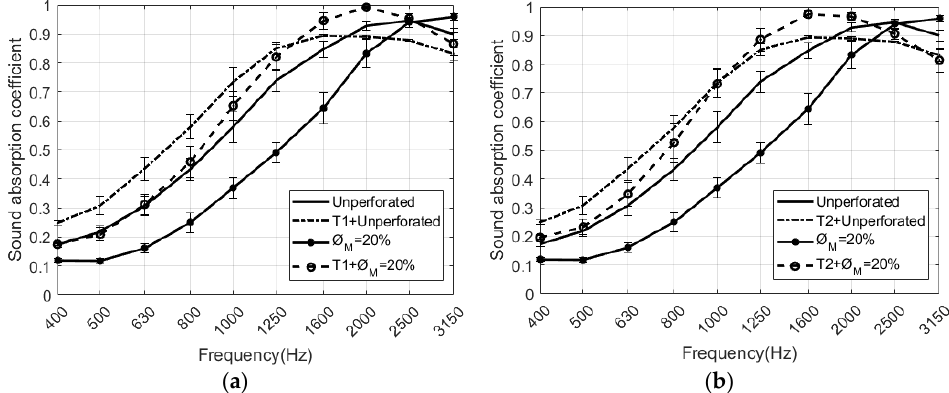
Figure 12. Results of the sound absorption coefficient at normal incidence of the different combinations between unperforated and perforated RPU samples and textile fabrics (T1 and T2): ( a ) ∅ M = 20%, D = 4 mm, T1; ( b ) ∅ M = 20%, D = 4 mm, T2.